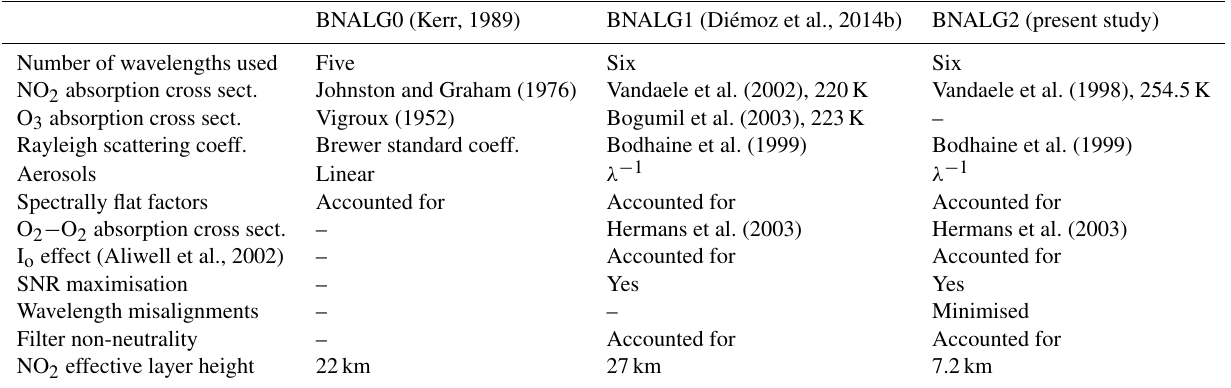
Table 2. Working principles of various algorithms for NO 2 direct sun retrievals with MkIV Brewers. BNALG0 (Kerr, 1989) BNALG1 (Diémoz et al., 2014b) BNALG2 (present study) Number of wavelengths used Five Six Six NO 2 absorption cross sect. Johnston and Graham (1976) Vandaele et al. (2002), 220K Vandaele et al. (1998), 254.5K O 3 absorption cross sect. Vigroux (1952) Bogumil et al. (2003), 223K – Rayleigh scattering coeff. Brewer standard coeff. Bodhaine et al. (1999) Bodhaine et al. (1999) Aerosols Linear λ − 1 λ − 1 Spectrally flat factors Accounted for Accounted for Accounted for O 2 − O 2 absorption cross sect. – Hermans et al. (2003) Hermans et al. (2003) Accounted for Accounted for Yes Yes Wavelength misalignments – – Minimised Filter non-neutrality – Accounted for Accounted for 22km